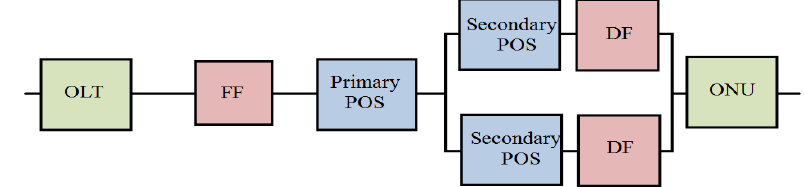
Figure 11. Reliability block diagram for (distributed fiber) DF protection architecture.